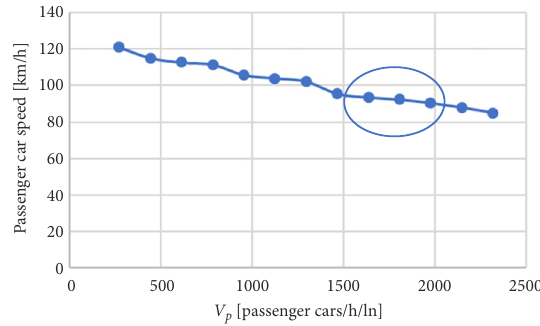
V [passenger cars/h/ln] p Figure 8. Modelled output – capacity of the on-ramp segment